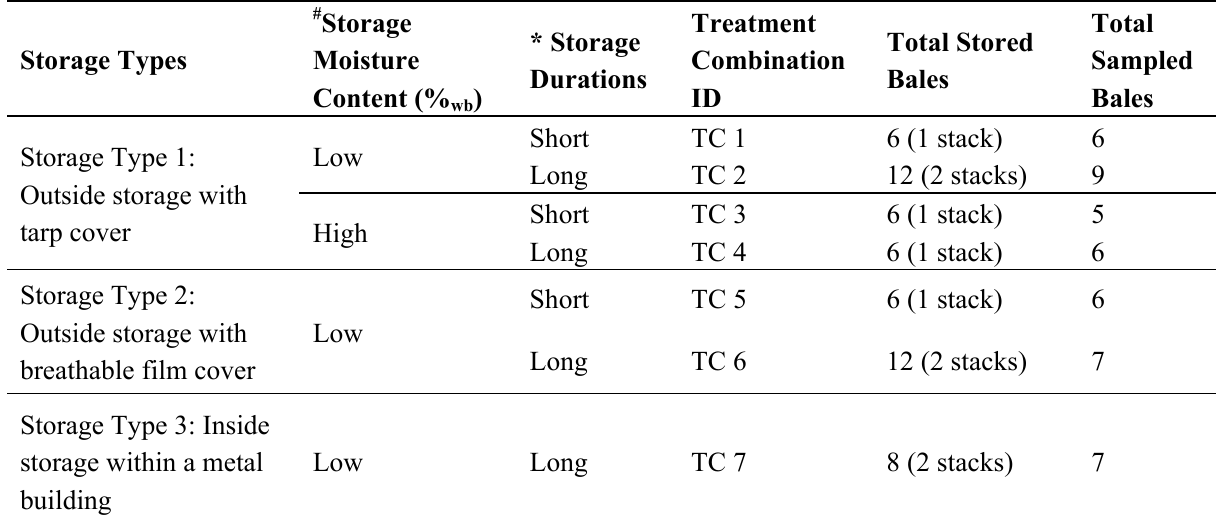
Table 1. Summary of different bale storage